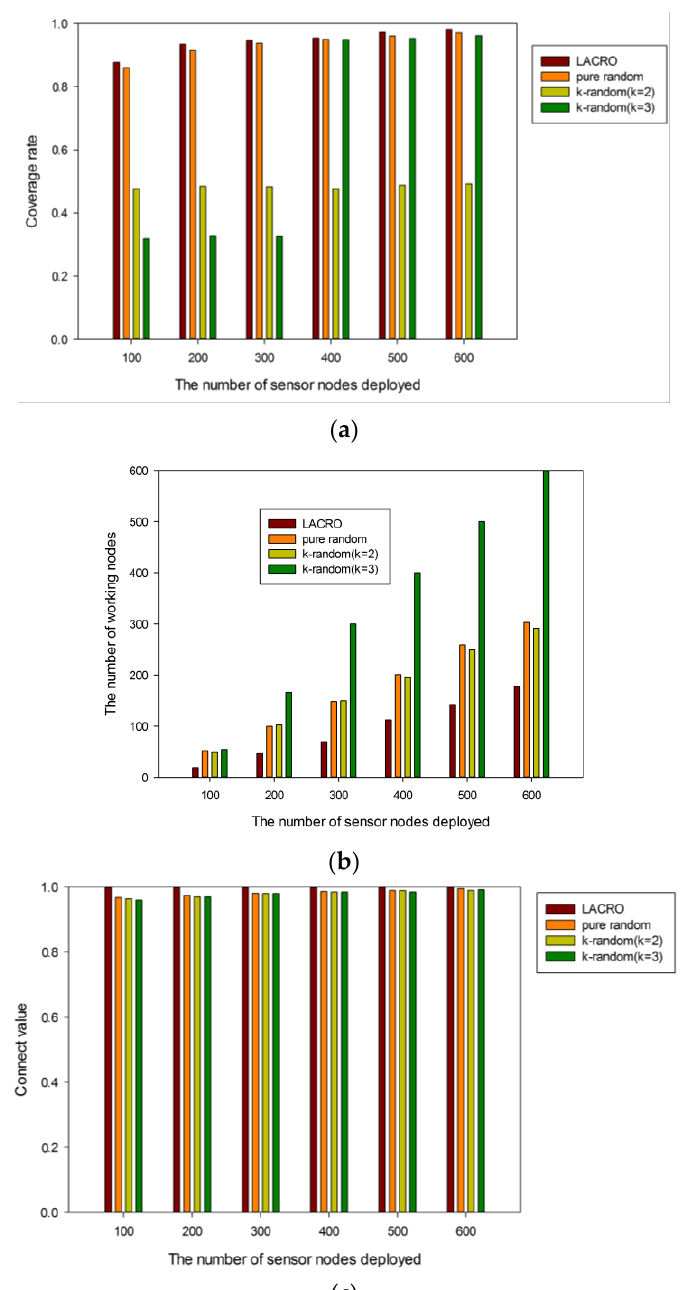
Figure 7. ( a ) Coverage rate f 1 vs. node density; ( b ) Ratio of working nodes f 2 vs. node density; ( c ) Connect value f 3 vs. node